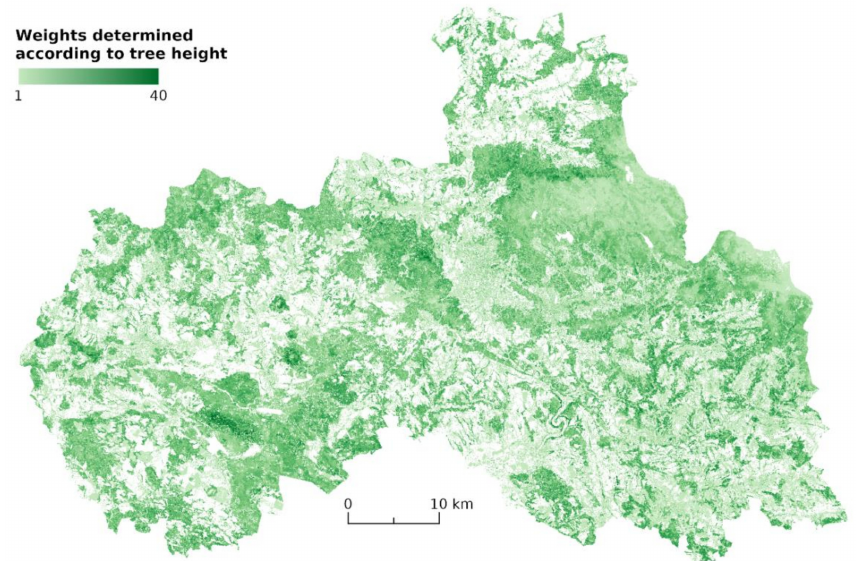
Figure 9. Raster with weights according to the average height of forest stands for Liberec Region in the period